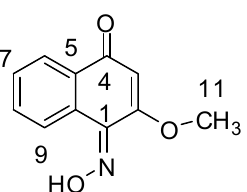
Figure 1. Structure of compound Z-4-2 .